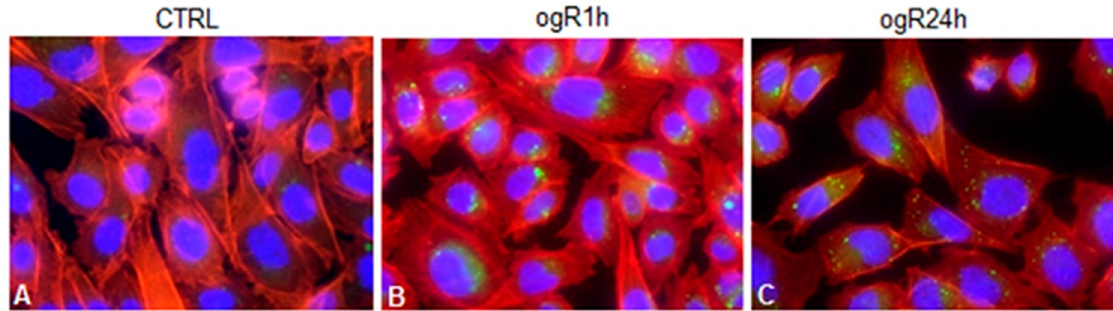
Figure 5. Lipid droplet (LD) staining in RBE4 after OGD/ogR. RBE4 cells were fixed in 4% paraformaldehyde and permeabilized at 4 °C with 0.5% Triton X-100 Hepes Buffer (4-(2-hydroxyethyl)-1-piperazineethanesulfonic acid. Images show LDs stained with BODIPY 493/503, actin filaments stained with phalloidin and nuclei stained with DAPI (blue fluorescence) in control ( A ), ogR1h ( B ), and ogR24h ( C ) RBE4 cells. Fluorescence images were collected under a Nikon Eclypse microscope with immersion objective at 60× magnification.